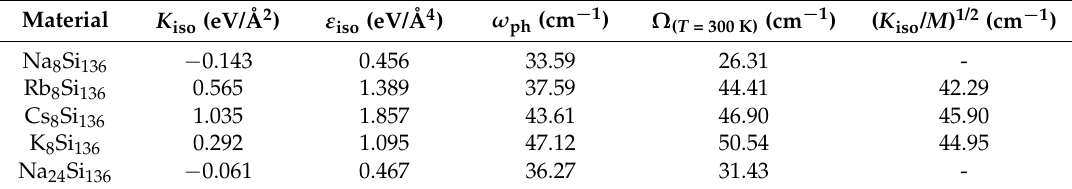
Figure 6. The potential energy curves for alkali atoms K, Rb, and Cs inside the Si framework. X represents the motion direction with respect to the alkali atom. Table 1. Fitting parameters of the guest-host interaction energy potentials for A 8 Si 136 (A = Na, K, Rb, Cs) and Na 24 Si 136